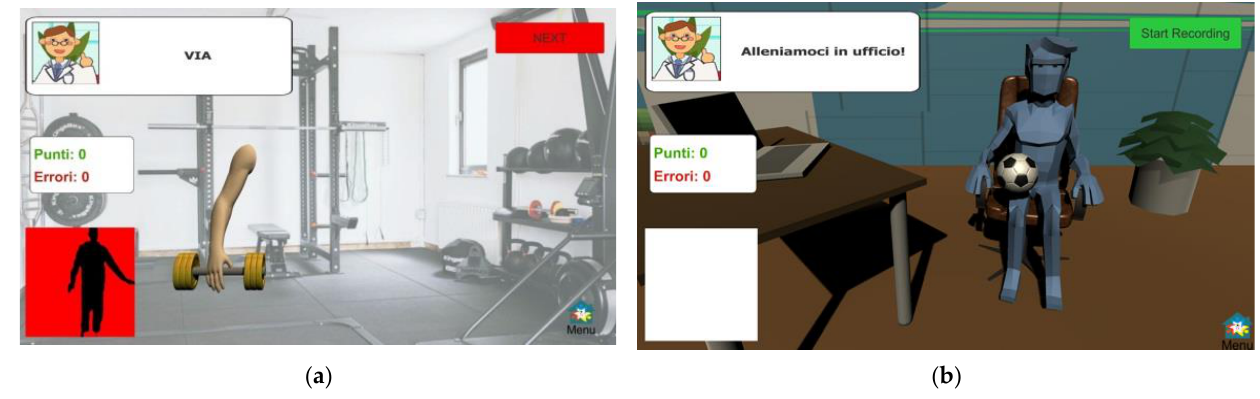
Figure 1. Screenshots of the main game scenes for the LWL/FWL ( a ) and BB ( b ) exergames during a patient’s game session. Textual messages and scoring board are used to guide the user’s